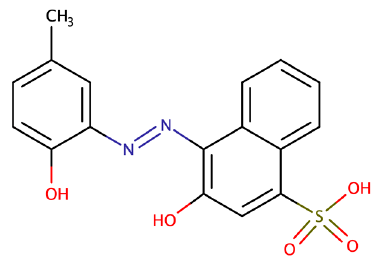
Figure 1. Molecular formula of calmagite.